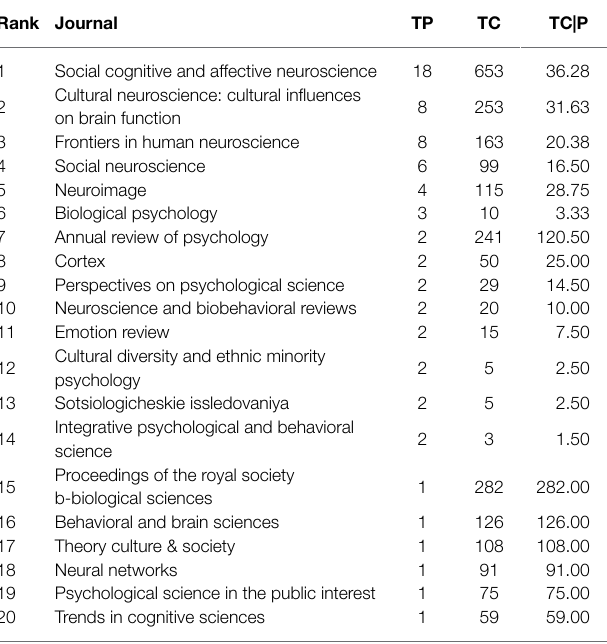
was created in the field of cultural neuroscience as shown in Figure 2 . It contains a total of 27 nodes, with each node representing a country and the line indicating the existence of a collaboration relationship between countries; the thicker the line, the closer the collaboration relationship. The size of the circle reflected the number of papers in a country, and the larger the number of papers, the bigger the circle. A total of 23 nodes (countries) in 27 countries formed the largest connected branch, showing that the four countries of Bulgaria, Netherlands, Poland, and Turkey have no collaboration relationship with other countries. The largest network components also represented major contributors to the field of cultural neuroscience. Researchers usually extract the largest connected branch and use its network structure characteristics to analyze the characteristics of the overall collaboration network (Gonzalez-Alcaide et al., 2015). The largest connected branch in the figure contained the three countries with the highest centrality: The United States (degree = 12), Germany (degree = 12), and China (degree = 12). These core countries have cooperated more than three times. The research trend in the field is represented by the national collaboration in different regions: the collaboration between high-yield countries/regions of rich clubs (McAuley et al.,